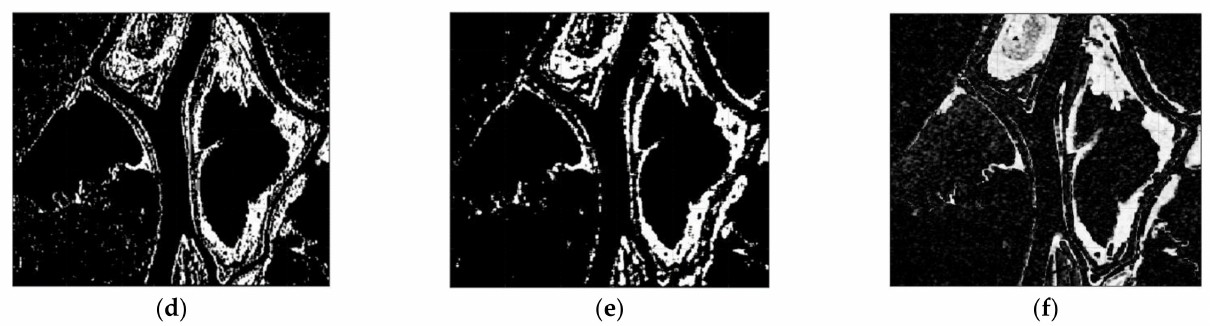
Figure 8. CDMs using dataset 2 obtained by six CD algorithms before median filtering in the post processing step. ( a ) CDM reconstructed by the CC. ( b ) CDM reconstructed by the LMT. ( c ) CDM reconstructed by the NRA. ( d ) CDM reconstructed by the SEST. ( e ) CDM reconstructed by the BGD. ( f ) CDM reconstructed by the proposed method.